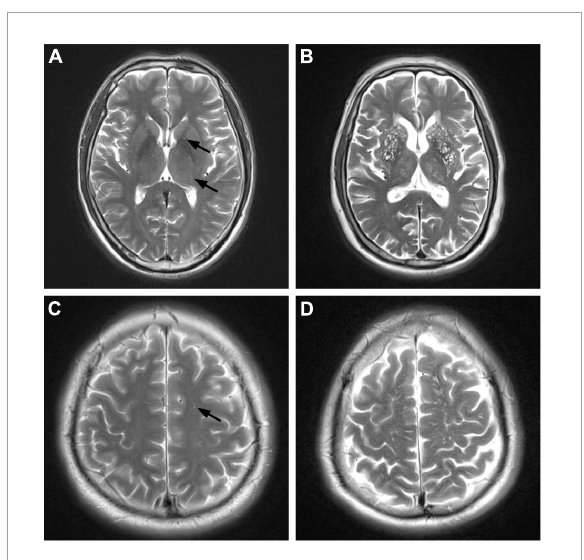
FIGURE2 Magnetic resonance imaging (MRI) manifestations of different degrees of enlarged perivascular space (EPVS) (T2-weighted imaging). BG, basl ganglia; CS, centrum semiovale. (A)